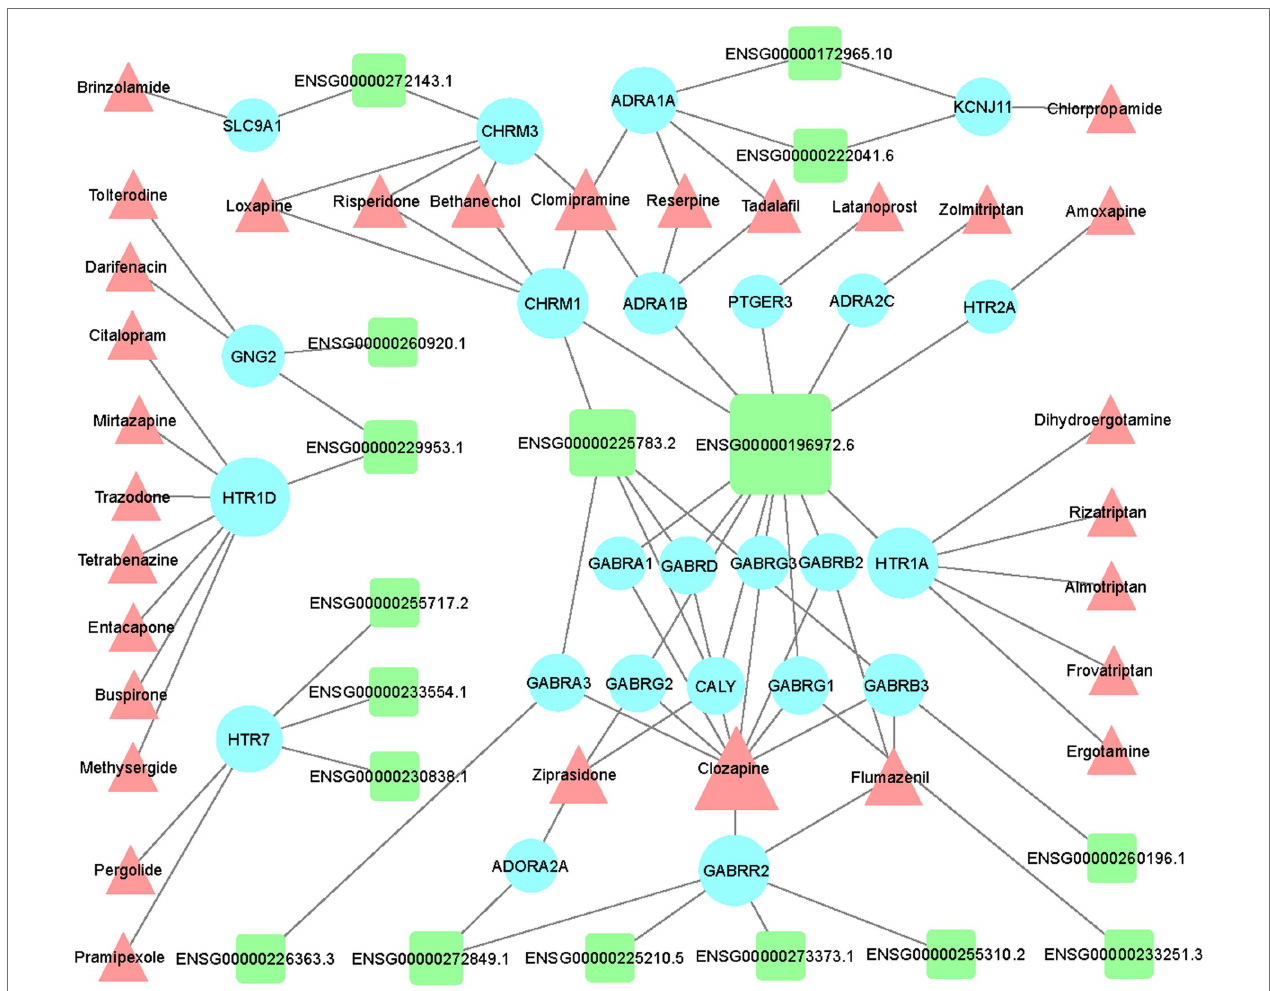
FIGURE 5 | Network visualization of the LncRNA-mRNA-drug interactions in GBM. Visualization of interaction network between differentially expressed LncRNAs and top 150 drug-target interactions (DTIs) predicted by DTINET. LncRNAs, targets (mRNAs), and drugs are shown in green round rectangles, blue circles and pink triangles,